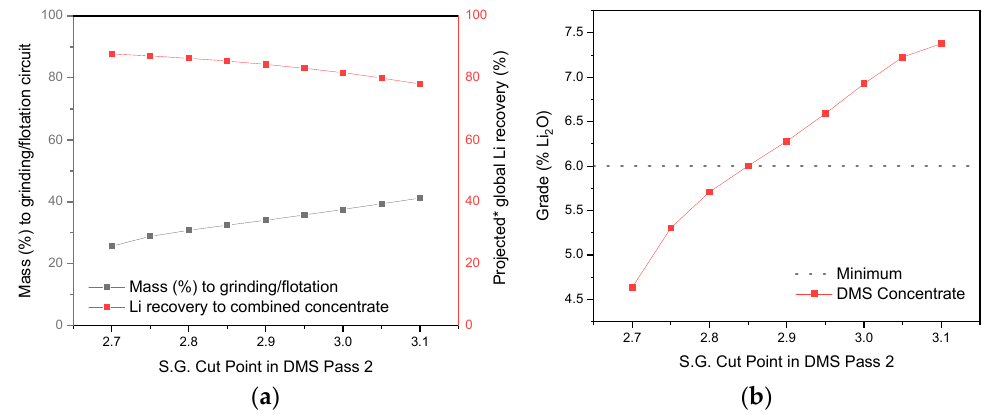
Figure 12. The effect of changes in the specific gravity cut point of DMS Pass 2 on ( a ) mass recovery and global lithium recovery, and ( b ) DMS concentrate grade.